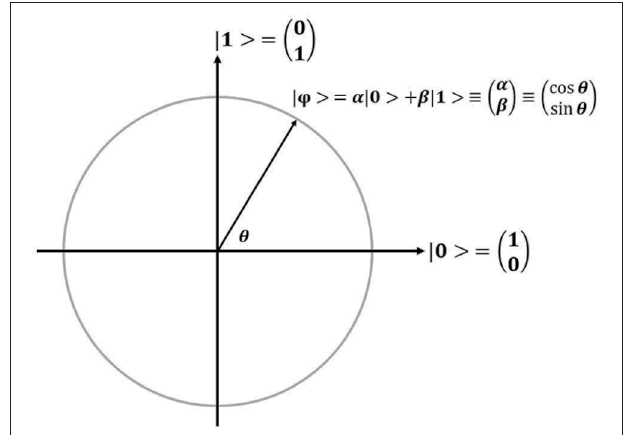
FIGURE 4 | Schematic illustration of a qubit. For the convenience of description, a qubit | φ > is simply denoted by ( α , β ) or ( cos θ , sin θ ).